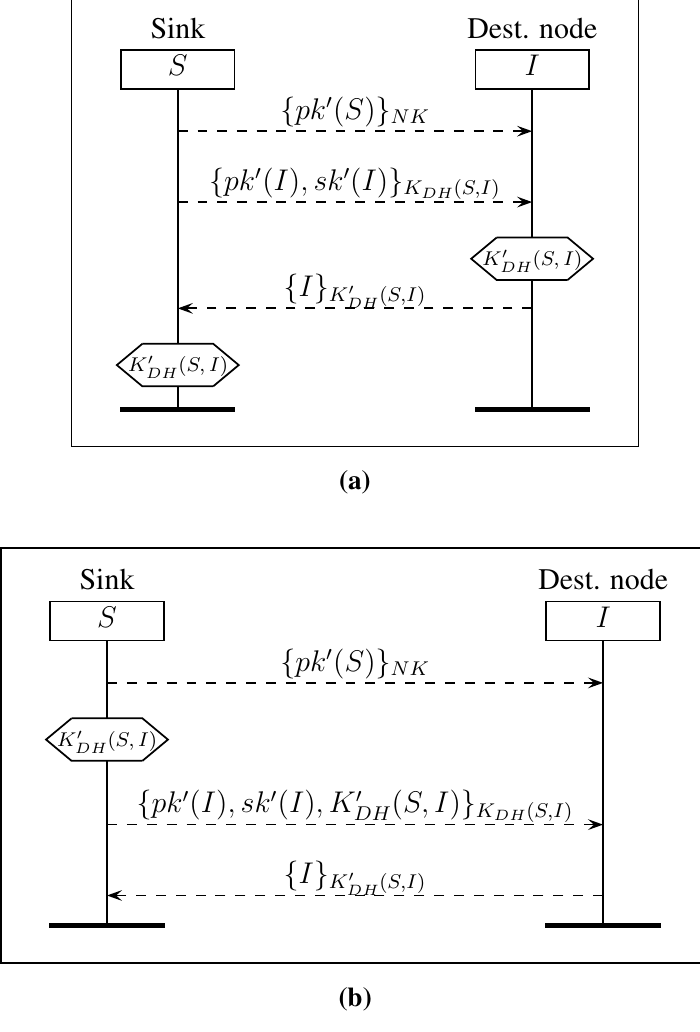
Figure 4. Two protocols for renewing asymmetric keys of a node I , where S uses the network key NK to broadcast pk ′ ( S ) . ( a ) Protocol RAKnk : S and I compute K ′ ( S, I ) ; a DH ( b ) protocol RAKnk : S computes K ′ ( S, I ) and sends it to I b DH